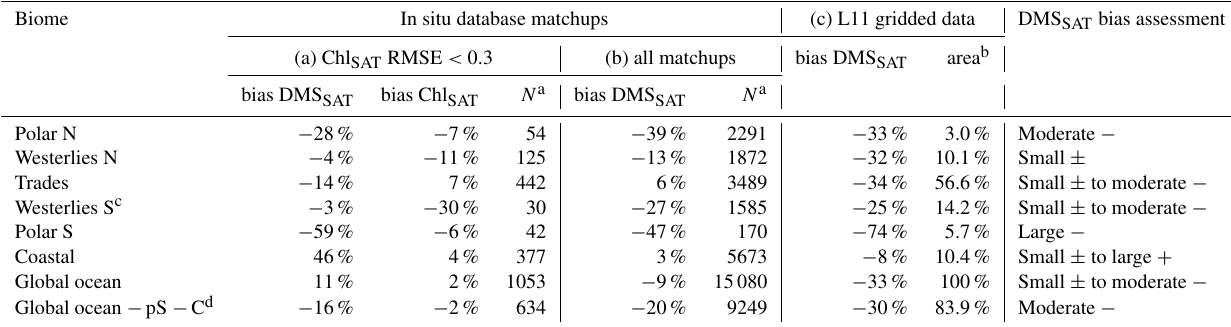
a For the database comparisons, the amount of data ( N ) available for validation in a given region depends on the total amount of measurements, the proportion of data points with satellite matchups and, for the constrained case, the fraction of matchups where Chl SAT has log 10 RMSE < 0 . 3 compared to concurrent Chl in situ. Samples with available DMSPt measurements were excluded because they were used in model fitting and optimization. b For the global climatology comparison we report the percentage of ocean area, excluding pixels that could not be observed by satellites (high-latitude winter). c Samples where DMSPt was measured (not excluded) for this biome due to the small amount of data. Removing them would leave N = 13 . d Global ocean minus Polar S and Coastal